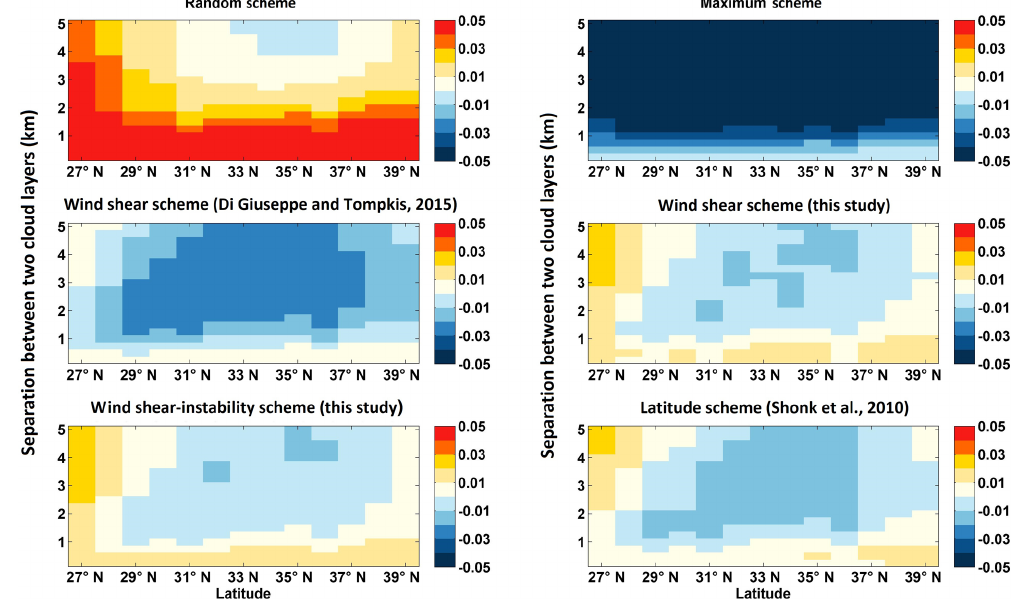
Figure 7. The zonal differences in total cloud cover (unitless) between calculation and observation for different schemes (see Table 1) and their dependence on the layer